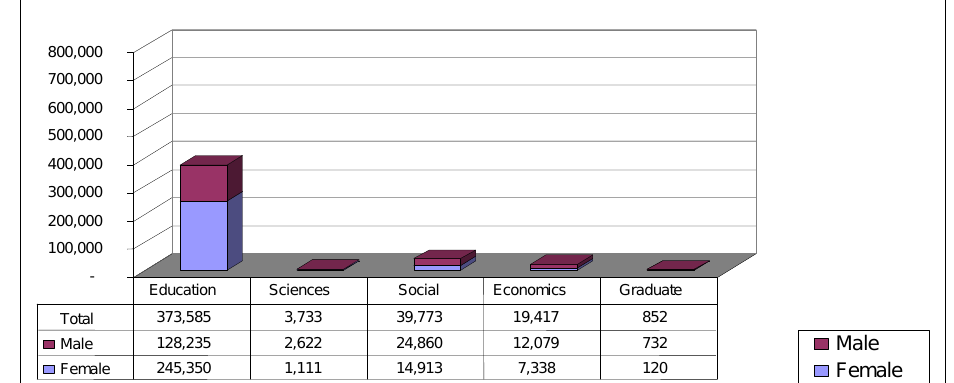
Figure 1. Number of students by Faculty and